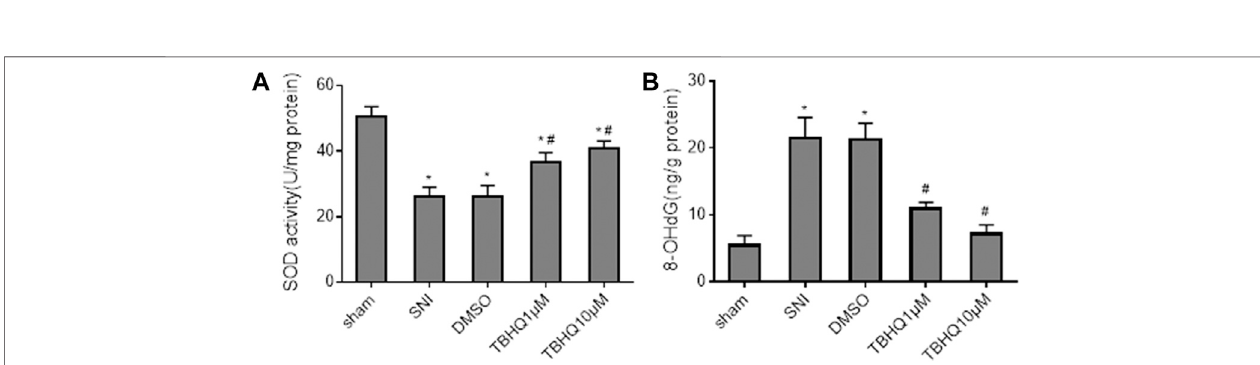
FIGURE4| Representative confocal images showingNrf2 immunoreactivity(red) in thespinal cord in SNI ratstreatedwith DMSO (vehicle) or Nrf2agonist tBHQ at 10 μ M. The nuclear staining by DAPI is shown in blue.